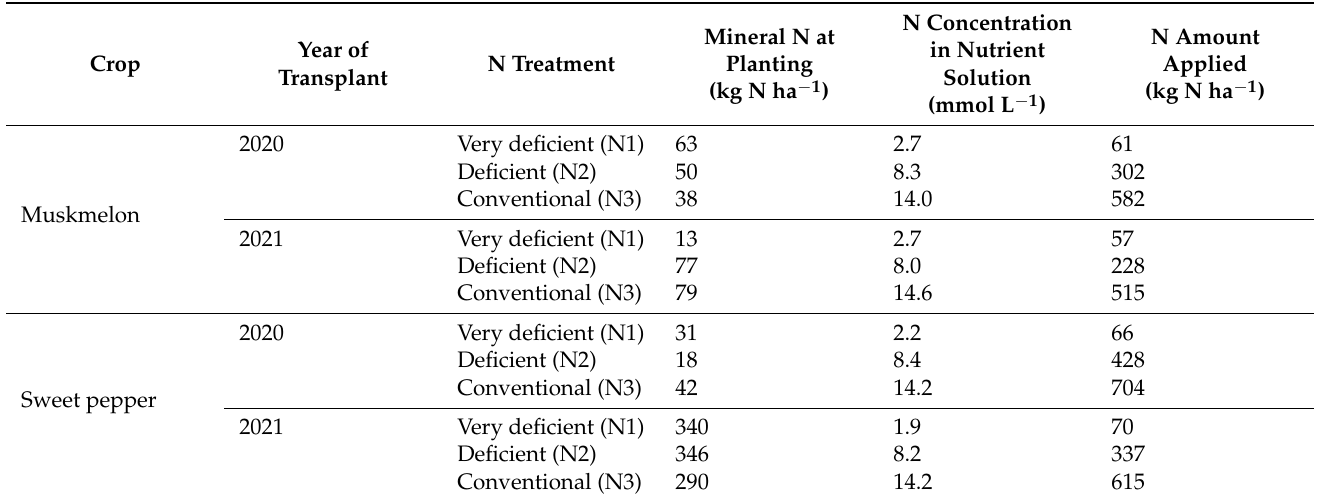
Table 1. Mineral N (NO 3– –N + NH 4+ –N) in soil (0–0.4 m depth) at the beginning of each crop, N concentration in the nutrient solution applied and mineral N amount applied in fertigation in the four